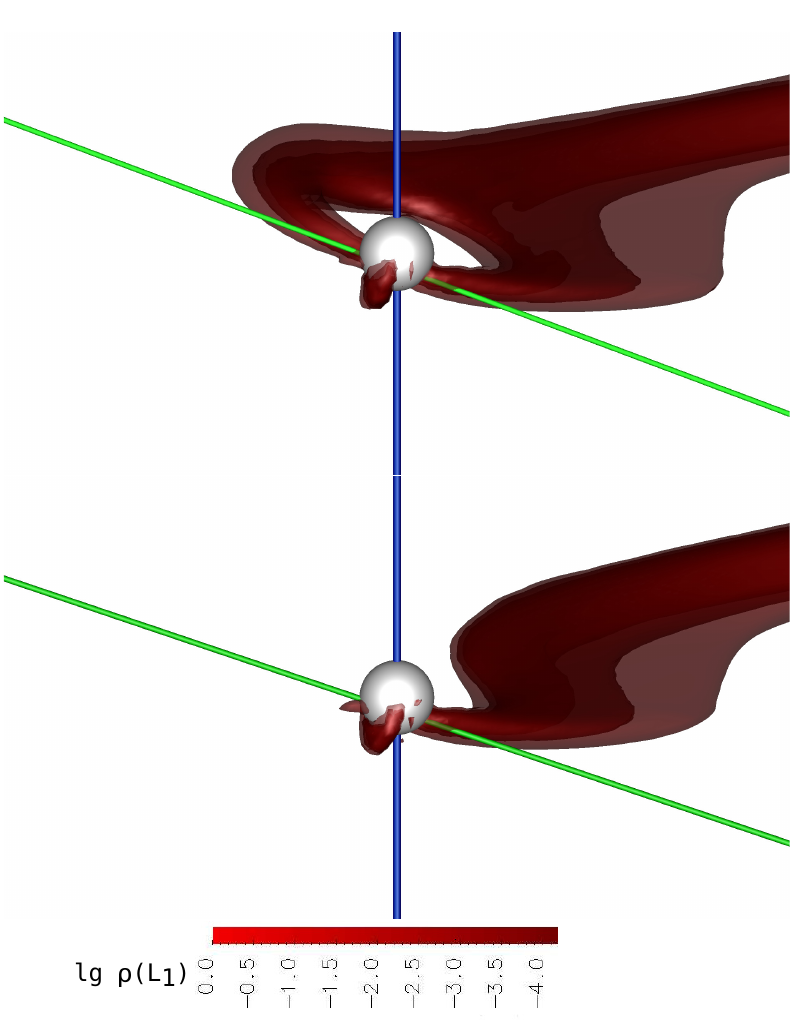
Figure 14. The same as in Figure 13 but for Phase 3 ( upper panel)) and Phase 4 ( lower